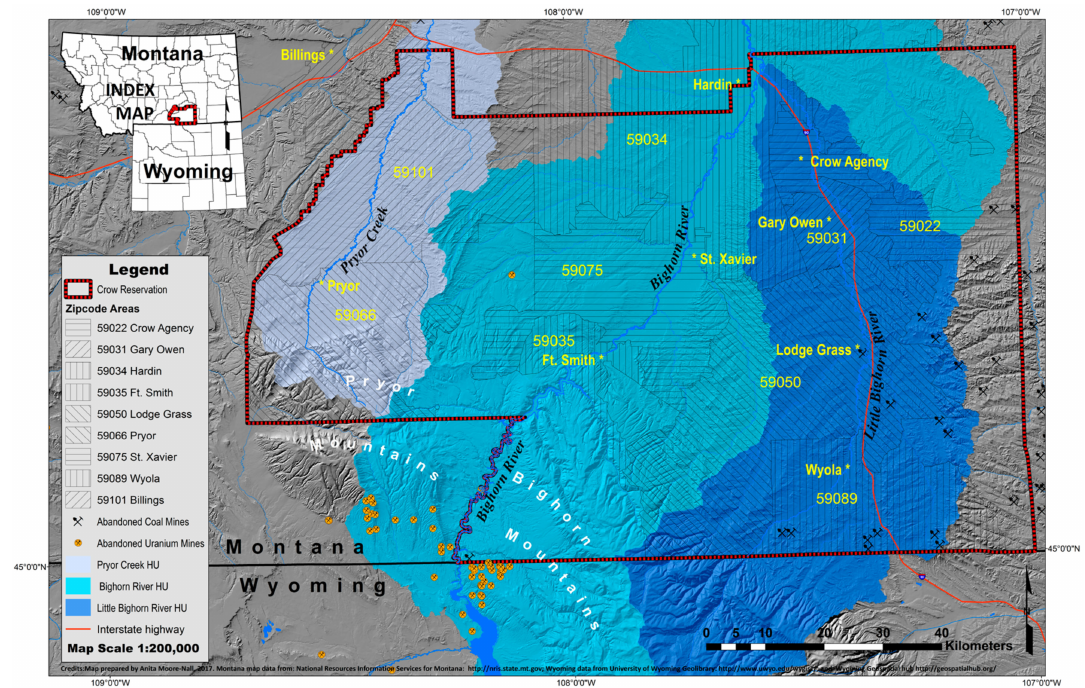
Figure 1. The local ZIP code regions are known to Reservation residents and map reasonably well to watersheds: Pryor and South Billings ZIP codes are in the Pryor Creek Hydrologic Unit (HU); Fort Smith, St. Xavier and Hardin fall within the Bighorn Lake and River HU; and the Wyola, Lodge Grass, Garryowen and Crow Agency ZIP codes comprise the Montana portion of the Little Bighorn River